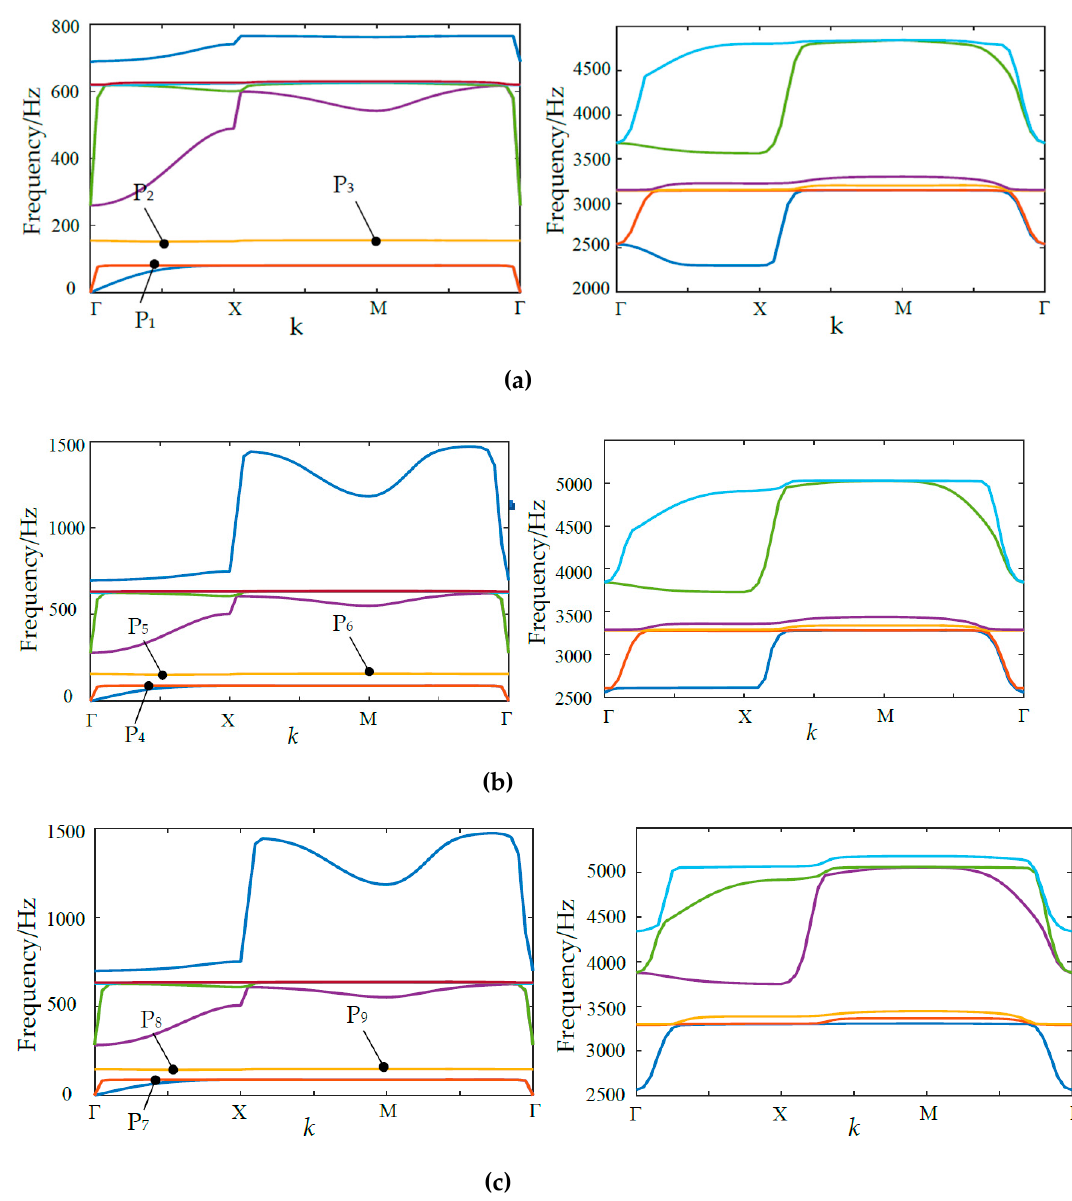
Figure 5. ( a ) Band structure of the PC with N 2 . ( b ) Band structure of the PC with N 3 . ( c ) Band structure of the PC with N 4 .